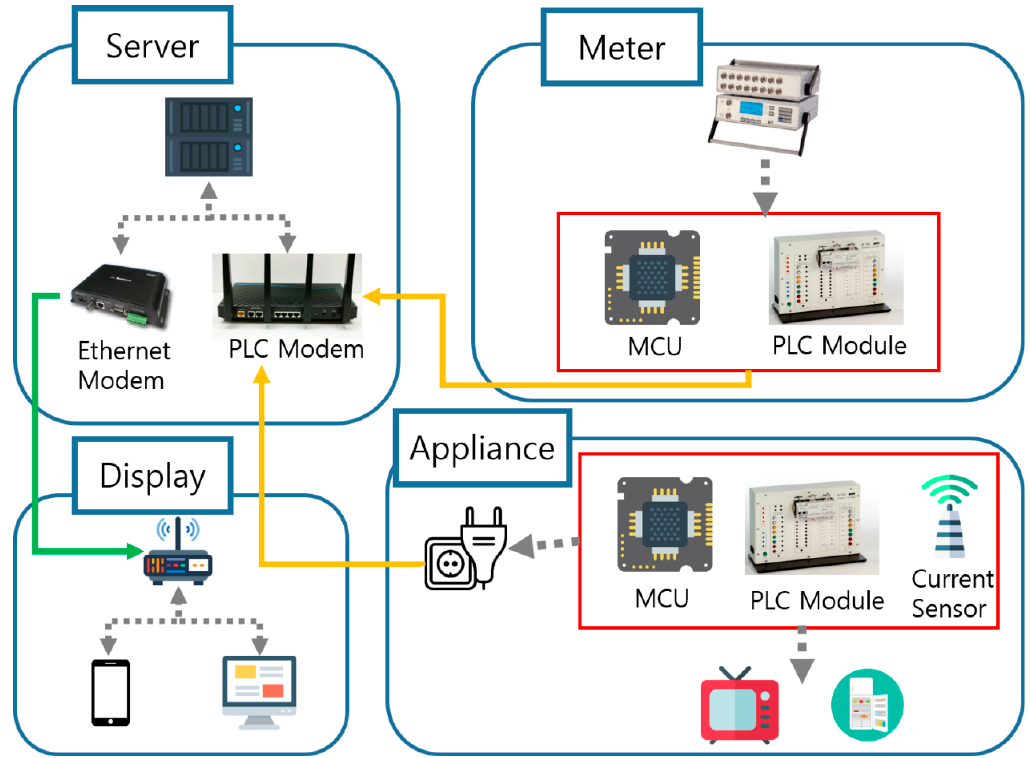
Figure 6. A Complete Functional Diagram.